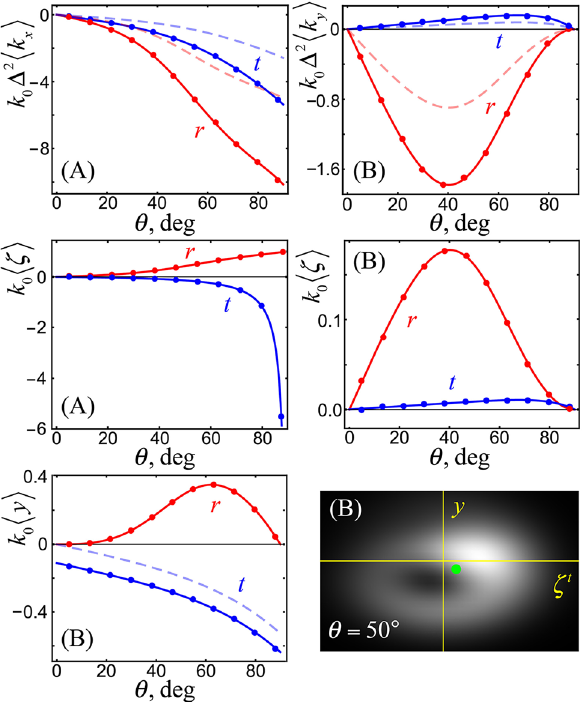
Figure 3: Theoretically calculated (curves) and numerically calculated (symbols) shifts of the reflected ( r ) and transmitted ( t ) STVPs in the cases (A) and (B) from Figure 2 as functions of the angle of incidence 𝜃 . The shifts are given by the sums of previously known polarization-induced contributions at 𝓁 = 0 (shown by pale dashed curves) and OAM-induced contributions Eqs. (6)–(9). The Δ = 500, and e , e ≡ ( e ) parameters are: 𝓁 = 1, n = 1 . 5, 𝛾 = 0 . 4, k ) ( √ √ 0 0 x y = 3 , (1 − i ) ∕ 3 . The density plot shows an example of the 1 ∕ Δ = 1 deformation of the transmitted pulse in the case (B) with k 0 and 𝛾 = 2 . 5 (to enhance the shifts with respect to the pulse size) and its centroid right after the refraction.